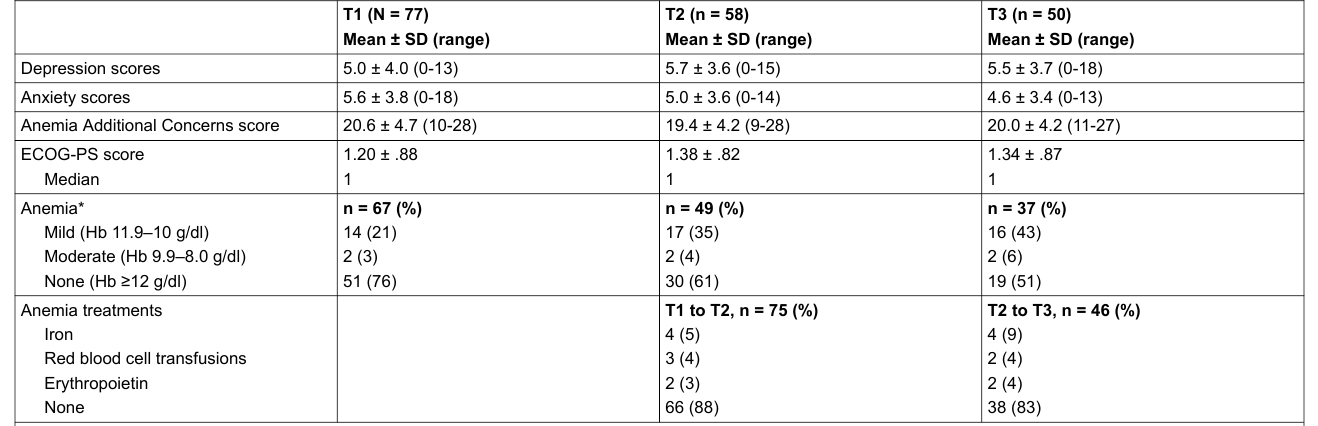
Table 2: Scores of depression, anxiety, other anemia-related symptoms, ECOG-PS, anemia and anemia treatments.